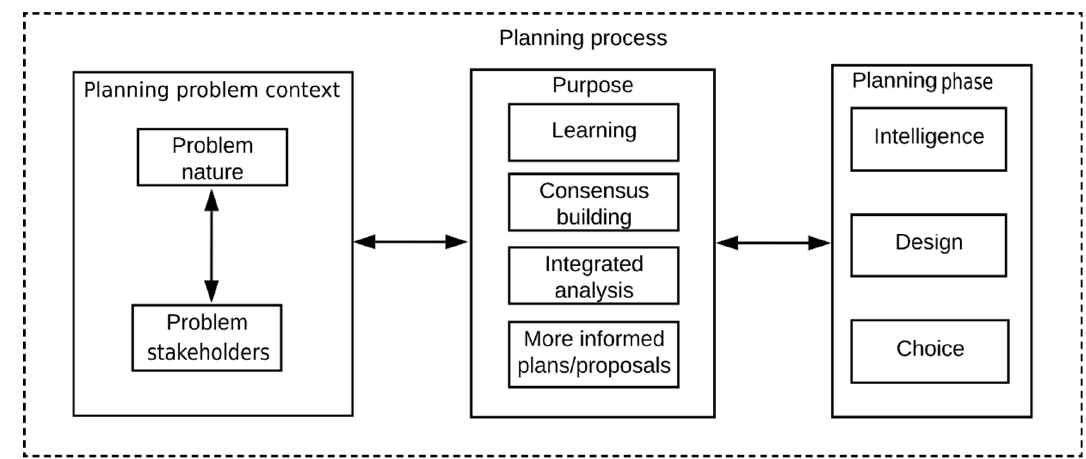
Figure 1. Map table-based planning workshop context. Source: Authors; based on [3,22,30]. Figure 1. Maptable-based planning workshop context. Source: Authors; based on